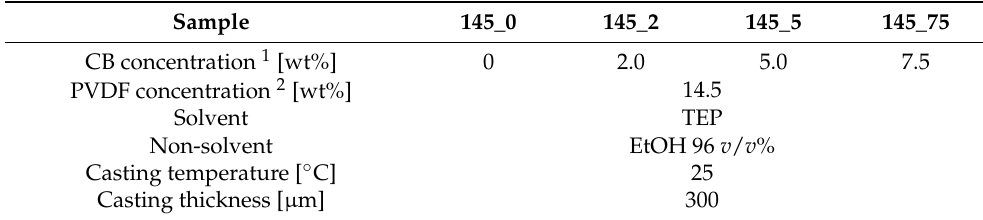
Table 1. Preparation conditions of the tested